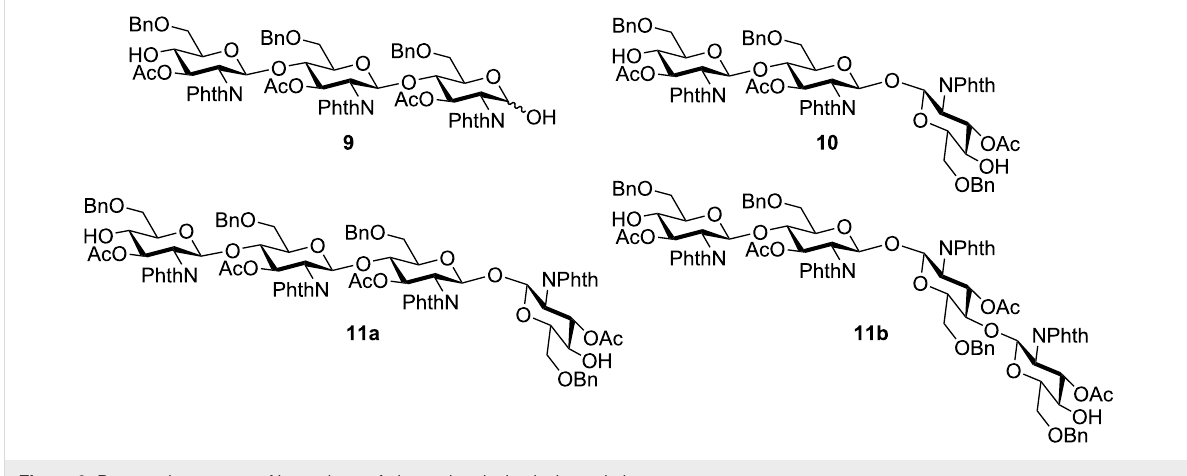
Figure 6: Proposed structures of byproducts of electrochemical polyglycosylation.